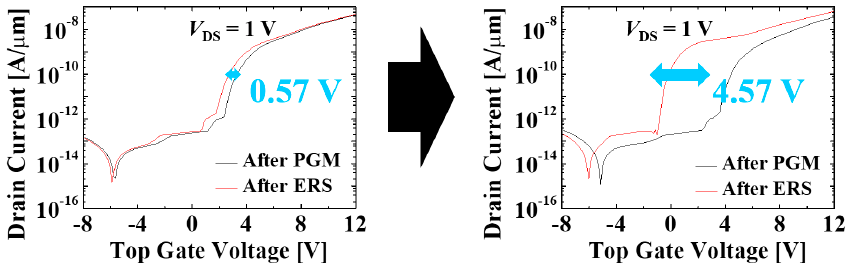
Figure 9. Enhancement of retention characteristics by the proposed tunneling oxide engineering. The graphs are calculated after 10 years of programming and